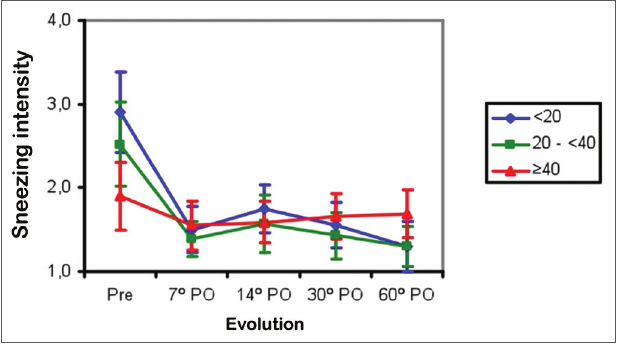
Figure 4. Mean bouts of sneezing/sneezing score in three age groups (years) in the preoperative (Pre) and postoperative (PO) periods.